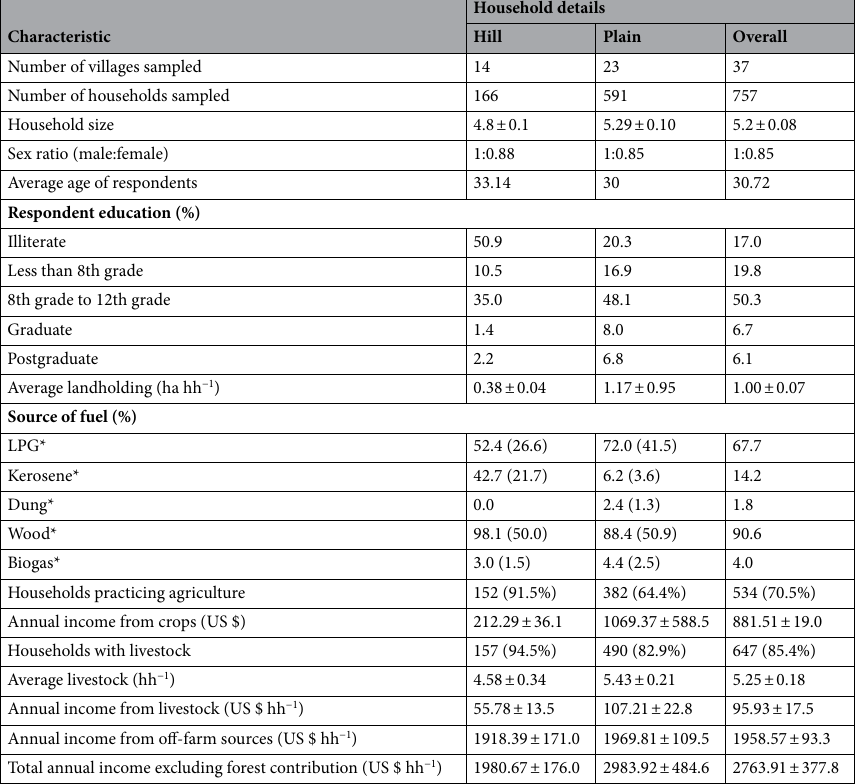
Table 1. Characteristics of respondents’ households in the forest corridor linking the Rajaji and Corbett Tiger Reserves, Uttarakhand, India. (* values in parentheses indicate percentage of total households sampled).